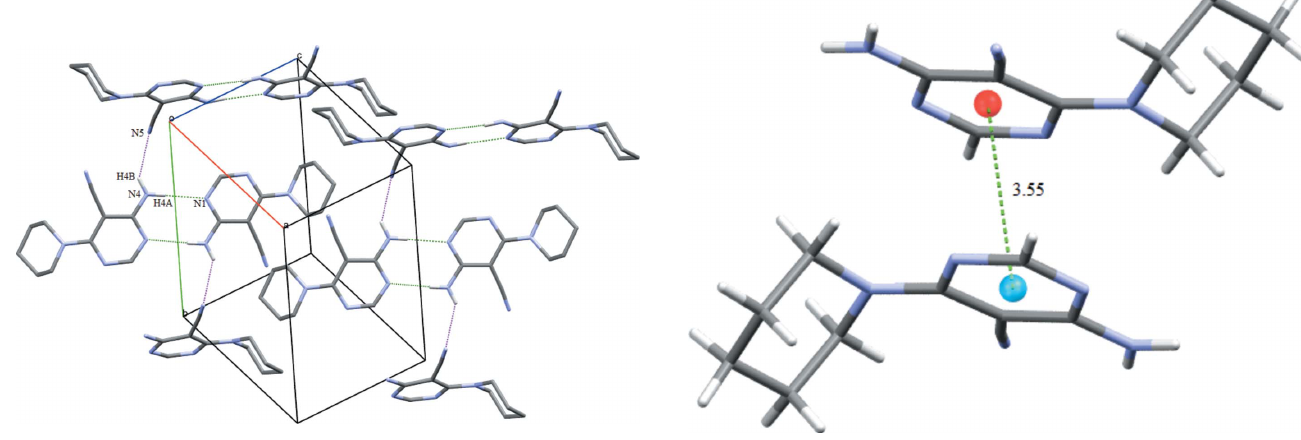
Figure 2 Unit-cell packing of the title compound showing N—H (cid:3)(cid:3)(cid:3) N interactions as dotted green and purple lines. H atoms not involved in hydrogen bonding have been excluded.